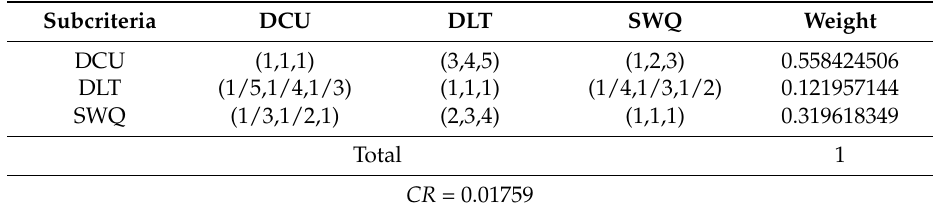
Table A11. Comparison matrix for